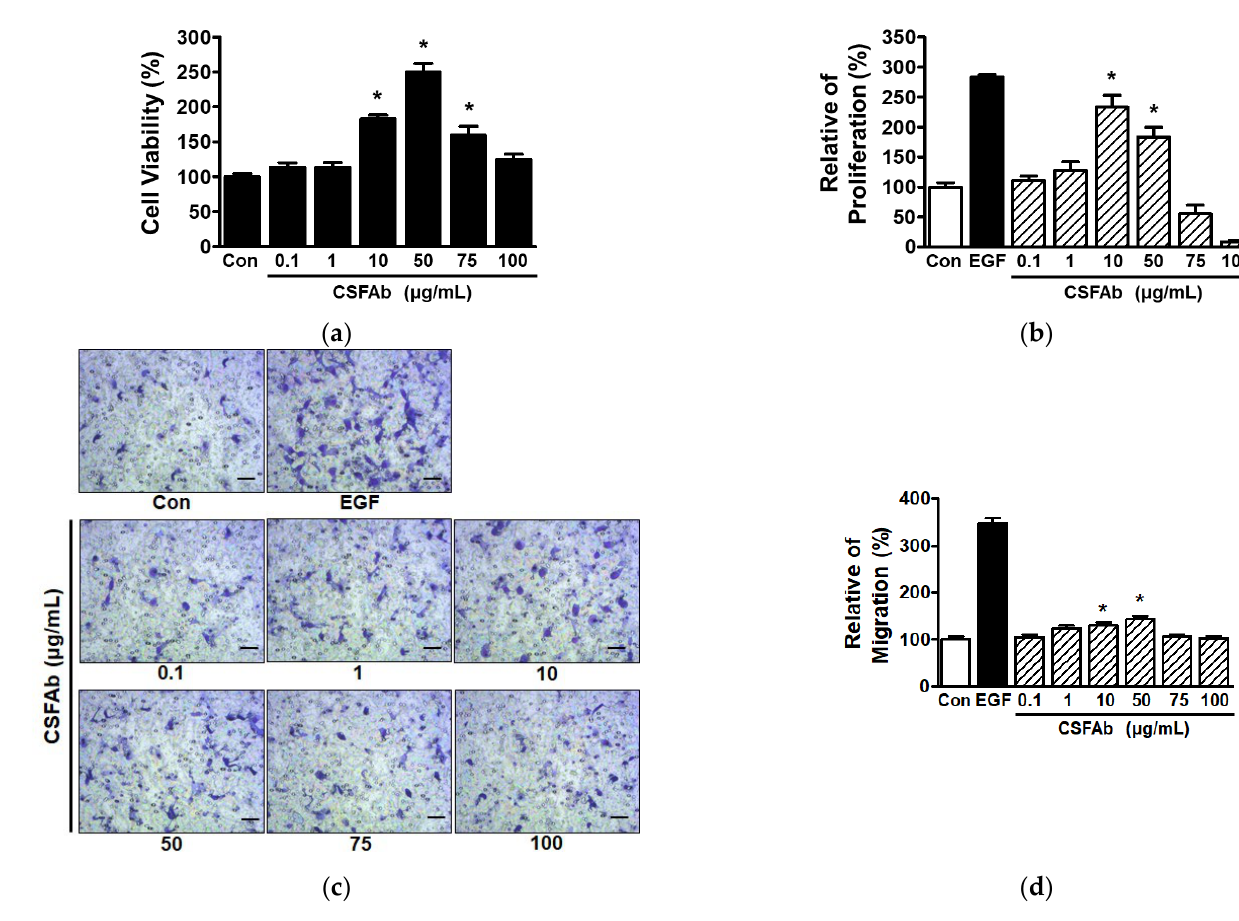
Figure 1. Effects of Caragana sinica flower absolute on the proliferation and migration of HaCaT cells. ( a ) Cell viability. HaCaT cells were incubated with or without Caragana sinica flower absolute (CSFAb; 0.1–100 μg/mL) for 48 h. Cell viabilities were evaluated using the WST assay ( n = 4). ( b ) Cell proliferation. HaCaT cells were treated with CSFAb (0.1–100 μg/mL) for 48 h. Proliferation was assessed using the BrdU incorporation assay detailed in Section 3. Recombinant human epidermal growth factor (EGF: 50 ng/mL): the positive control. Results are expressed as mean percentages ± SEMs ( n = 4) of untreated controls (Con). * p < 0.05 vs. untreated cells. ( c , d ) Cell migration. HaCaT cells were treated with CSFAb (0.1–100 μg/mL) for 4 h, and migrations were assessed using a Boyden chamber assay. ( c ) Representative images of experimental results. Violet spots indicate migrated cells. Scale bar = 50 μm. ( d ) Statistical graph of experimental results. Recombinant human epidermal growth factor (EGF: 1 ng/mL): positive control. Results are expressed as mean percentages ± SEMs ( n = 4) of untreated controls (Con). * p < 0.05 vs. untreated cells.